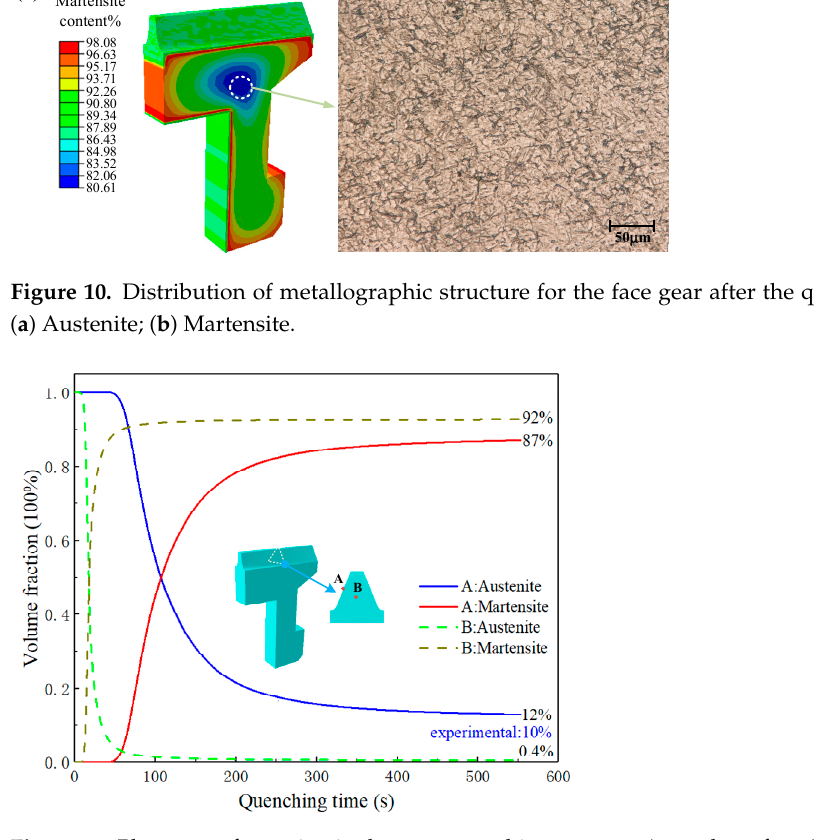
Figure 11. Phase transformation in the gear quenching process: A: tooth surface; B: tooth core.